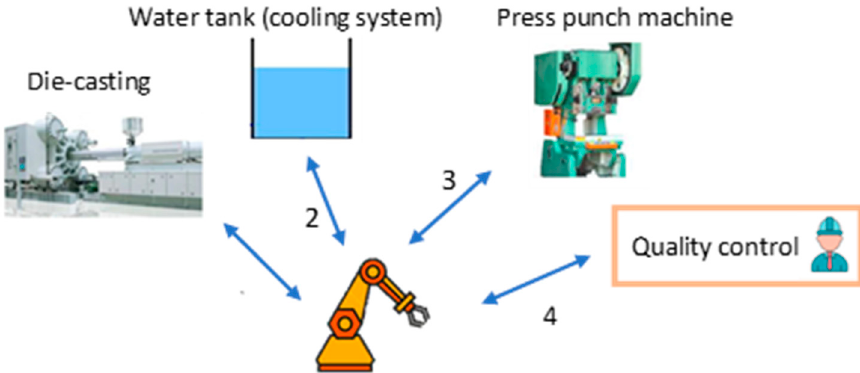
Figure 4. Workpiece process. The robot takes the part from the die casting machine (1) and sub- merges it in a water tank (2). The robot then inserts the part in a trim die, where excess material is face of the casting.